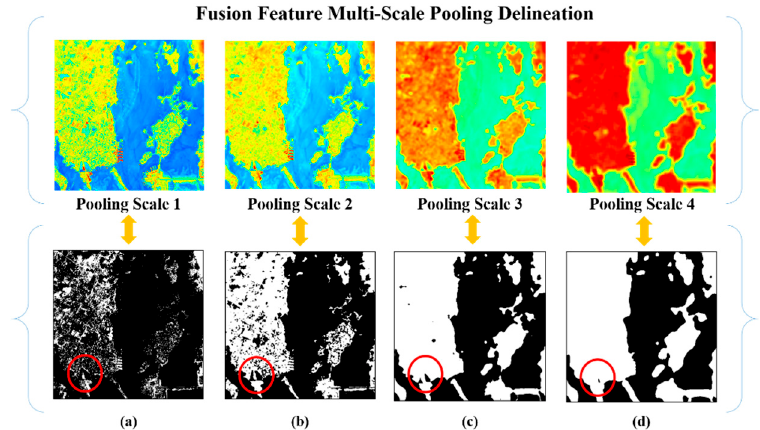
Figure 5. Fusion feature multi-scale pooling analysis. ( a – d ) show small to large pooling scale description with their corresponding binary marks. The red circle shows the detailed edge structure maintained using different pooling description scales.